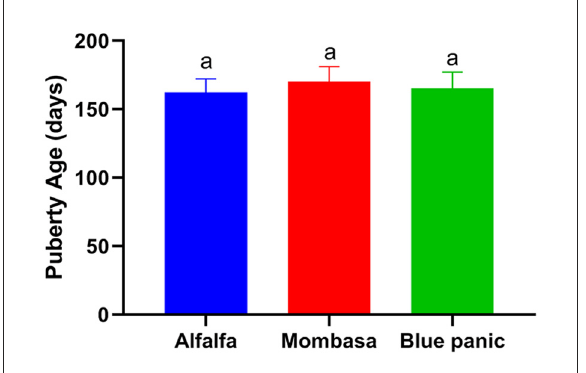
FIGURE1 Puberty age in goats fed with alfalfa, Mombasa or blue panic.